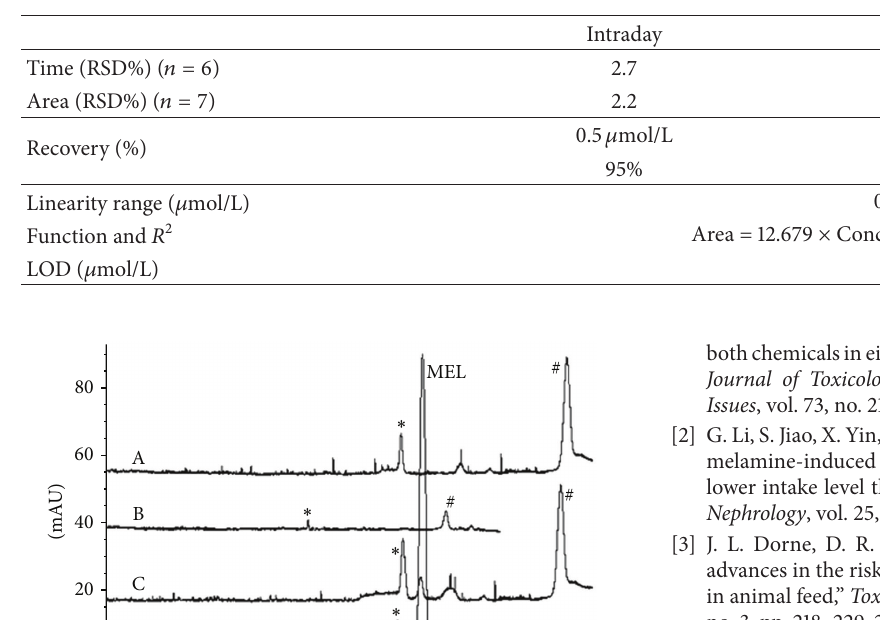
Table 1: Characters of established method.